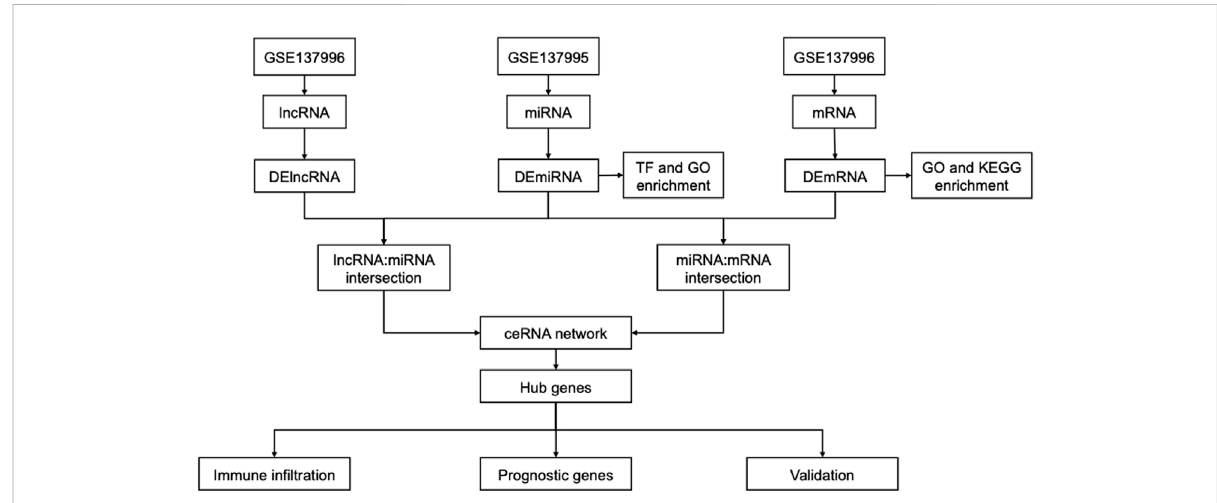
FIGURE 1 Flow chart of identi fi cation of ceRNA-related network hub genes in AAK.